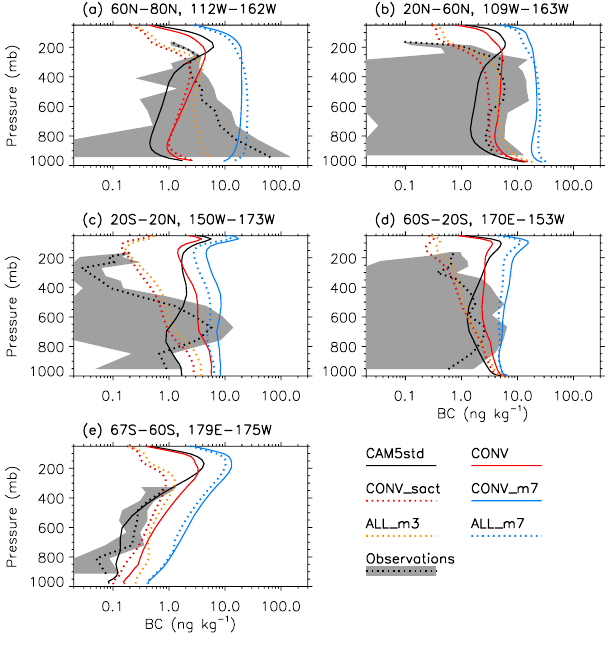
Fig. 6. Vertical profiles of BC mass mixing ratios (ngkg − 1 ) from HIPPO1 observations in January 2009 (dotted lines for the mean along flight tracks; shaded area representing one standard deviation on each side of the mean) and model simulations (colored lines for simulations described in Table 1). Profiles from model output (10yr January mean) are sampled along flight tracks within the latitude– longitude range for each